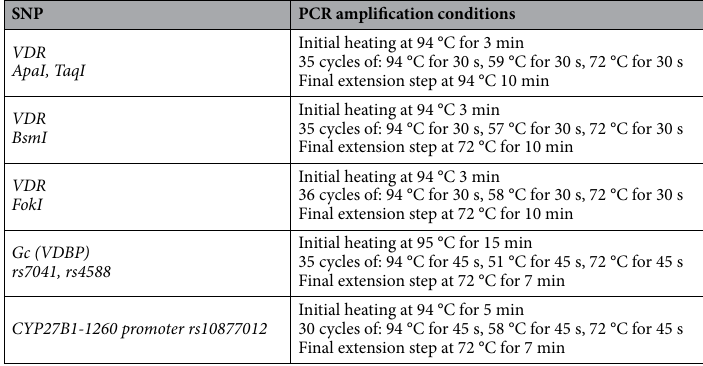
Table 1. PCR amplification conditions for each studied